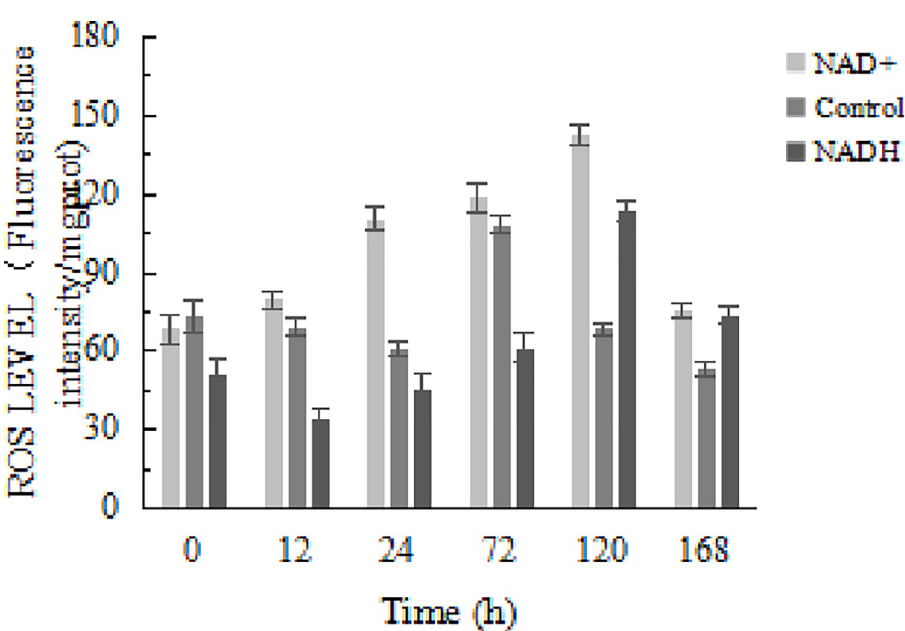
Fig 5. Effect of NAD + and NADH on changes in mitochondrial ROS